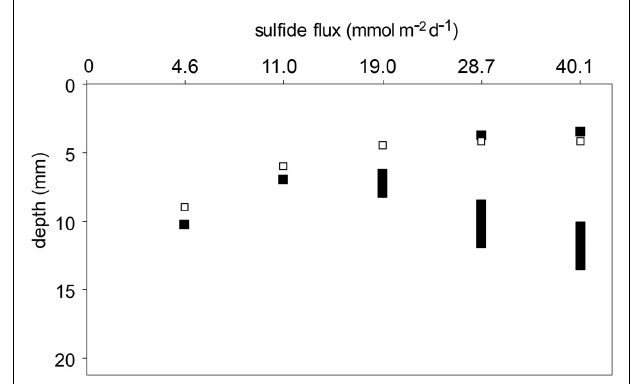
FIGURE 1 | Distribution of Beggiatoa sp. 35Flor filaments over depth in gradient cultures with different sulfide fluxes after 6 (open symbols) and 12 (closed symbols) days of cultivation. The flux values were estimated from measurements after 7days ( Table 1